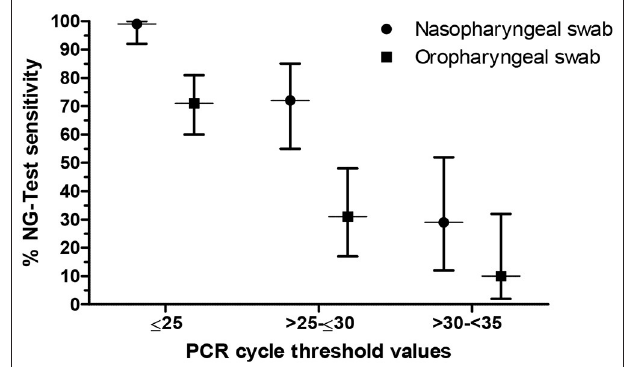
FIGURE 1 | Sensitivity of the NG-Test ® SARS-CoV-2 Ag (NG-Test) in respect to the viral load of clinical specimens. Vertical error bars represent the 95% confidence